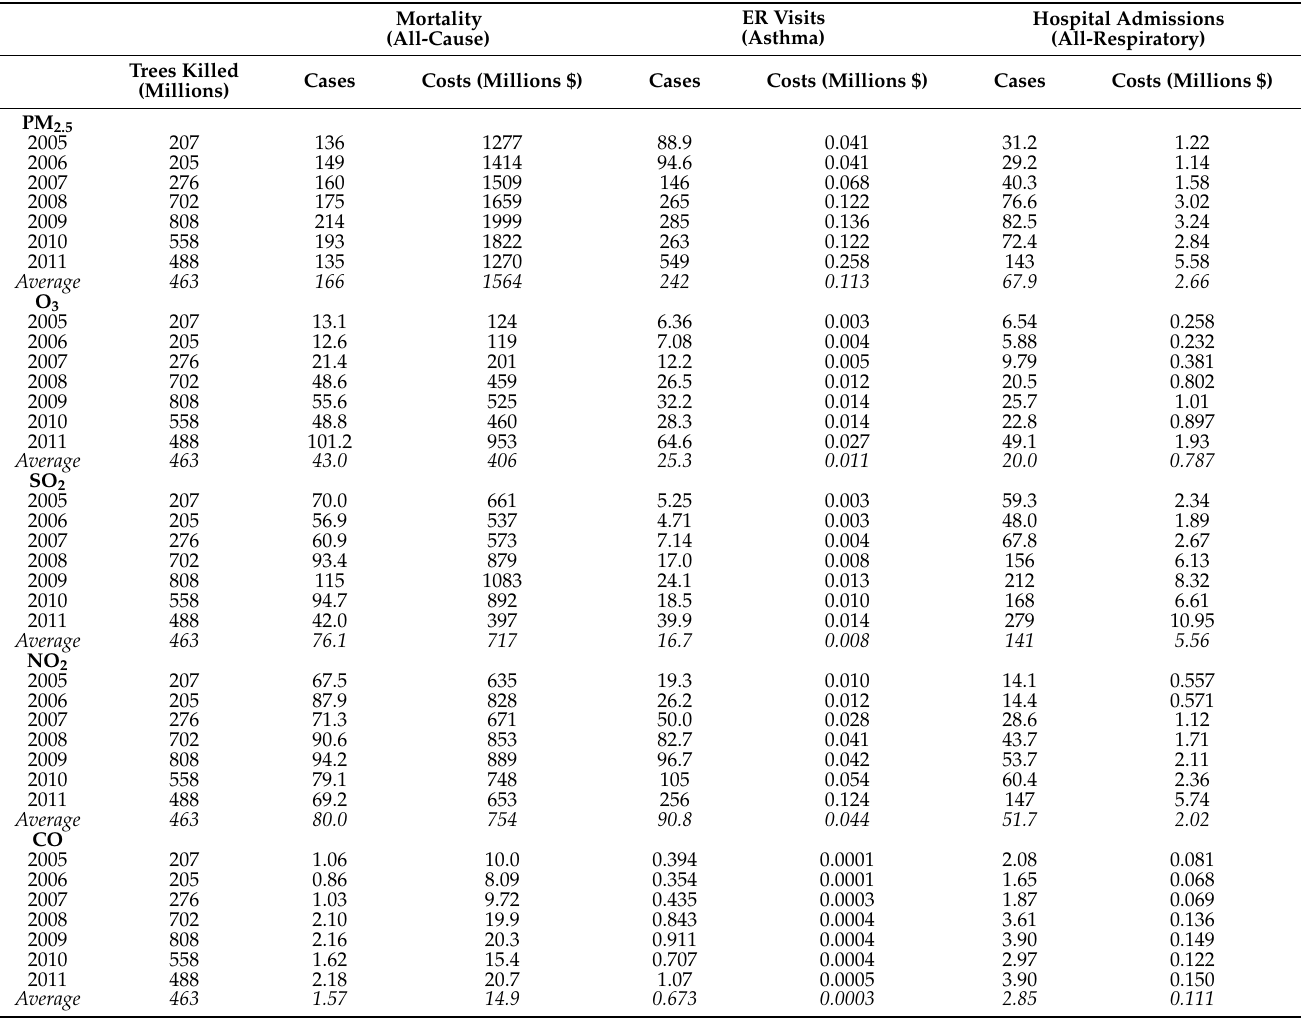
ER Visits (Asthma)